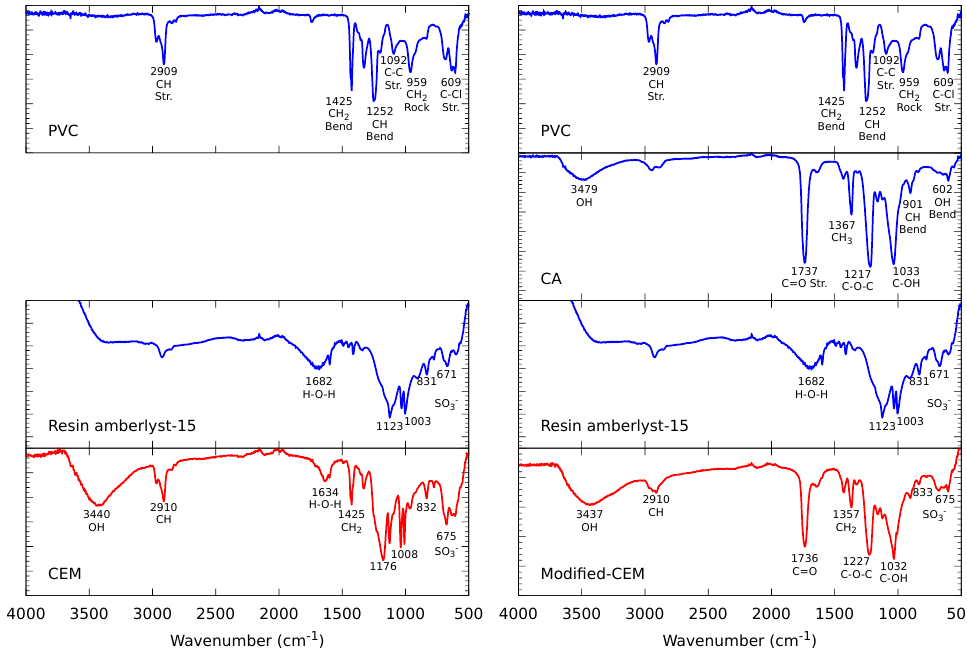
Figure 3. FTIR spectra of polyvinyl chlorid (PVC), cellulose acetate (CA) and pure resin Amberlyst-15 reagents, with the synthesized cation exchange membrane (CEM) and modified-CEM synthesized by solvent